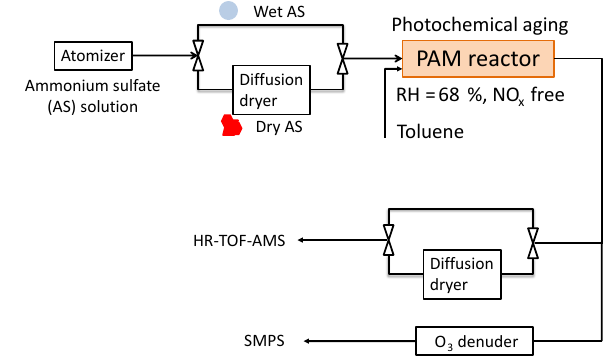
Figure 1. Schematic of the experimental setup. The aqueous am- monium sulfate (AS) seed particles either passed through a diffu- sion dryer so that the phase of the seed particles could be altered or bypassed the diffusion dryer. Either wet or dry AS served as seed particles for the